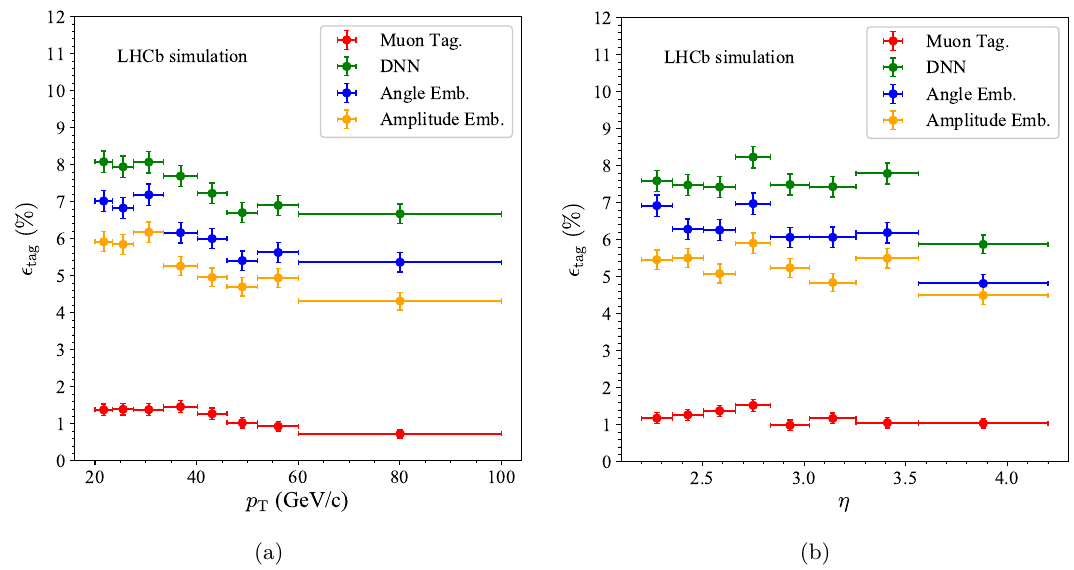
Figure 17. Unoptimised tagging power (cid:15) tag with respect to (a) jet p T and (b) jet η for the complete dataset. The angle embedding circuit and the DNN show similar